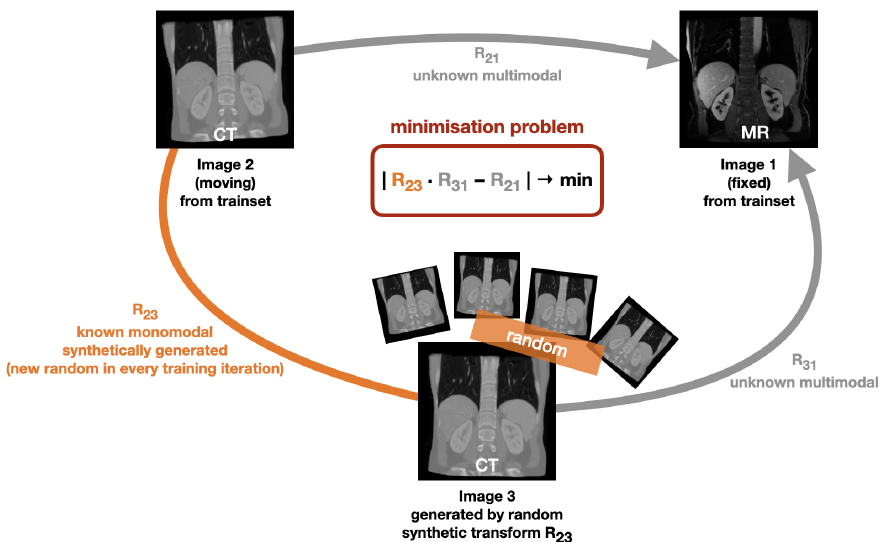
Figure 1. Our proposed self-supervised learning concept for multimodal image registration aiming to minimise a cycle discrepancy. In every training iteration, another (known) random transformation matrix R 23 is used to generate a synthetic image. Like this, a cycle consisting of two unknown multimodal transformations (with the transformation matrices R 21 and R 31 ) and a known monomodal transformation (with the transformation matrix R 31 ) is obtained, leading to the minimisation problem of | R 23 · R 31 − R 21 | → min that is used for